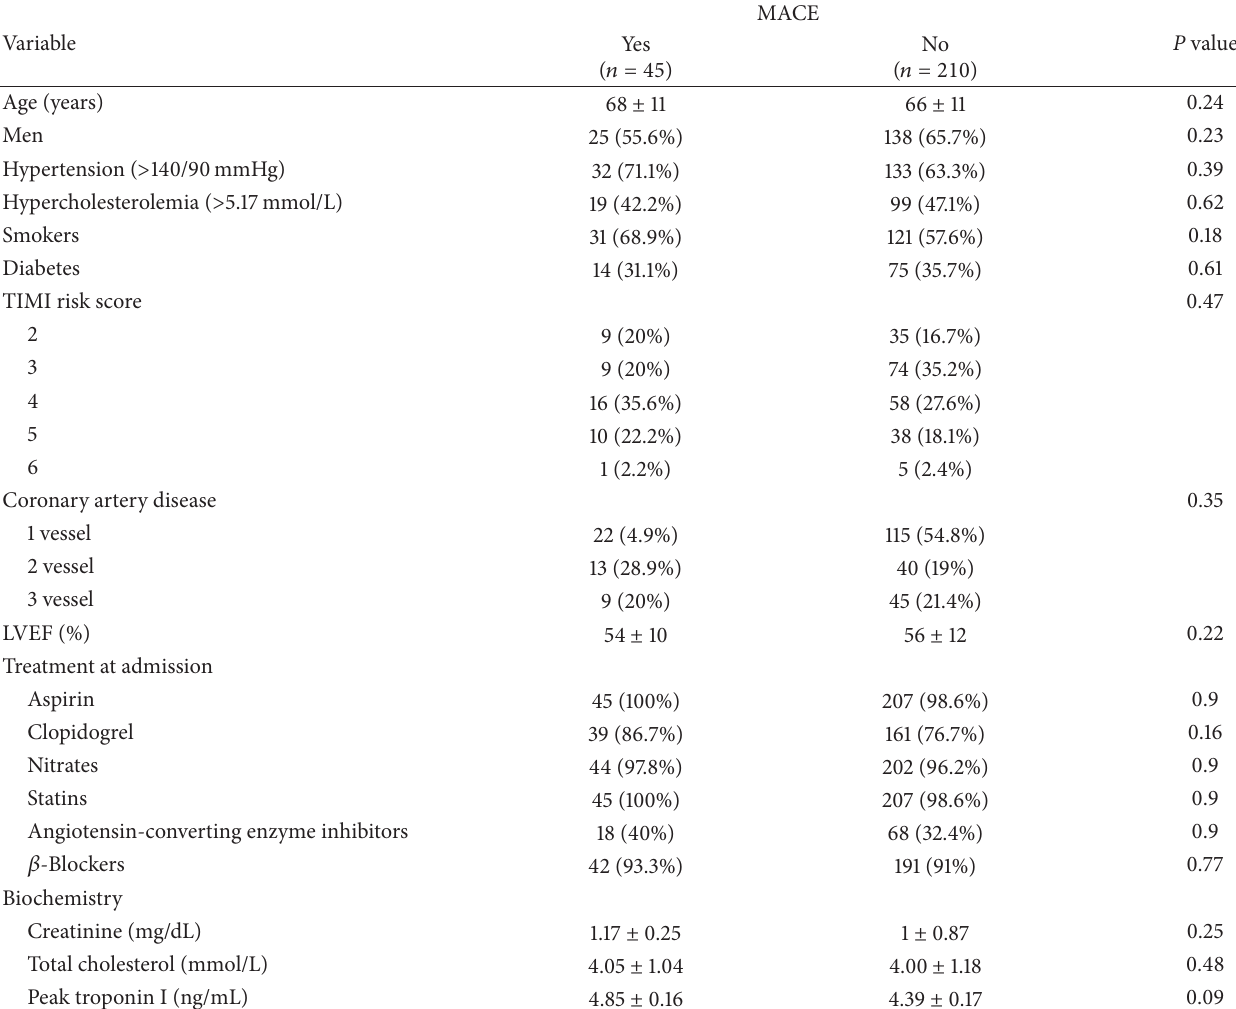
Table 1: Clinical variables of non-ST-segment elevation acute coronary syndrome patients with and without MACE at 36-month followup.